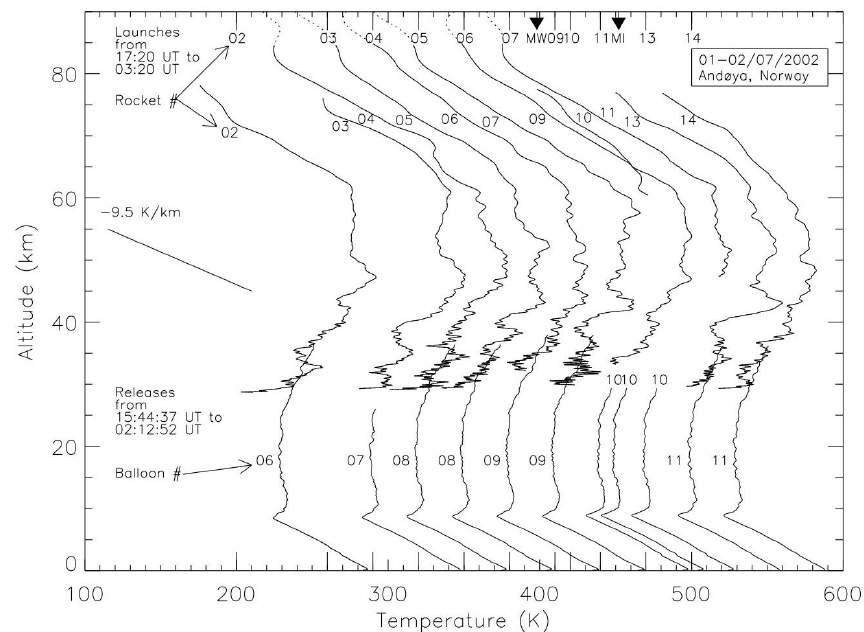
Fig. 7. Waterfall plot of the vertical temperature profiles measured by each rocket and balloon flight launched in the 1–2 July 2002 sequence at ARR and listed in Table 3. Each temperature profile is offset proportionally to the time between FS launches. The closest balloon measurement in time is matched with each rocket flight. The time for the MaCWAVE and MIDAS launches is indicated at the top. The profiles are dotted above 85km where the accuracy rapidly degrades. Note that the temperatures at the lowest altitudes for the falling spheres become distorted because of sphere collapse. This also applies to the profiles in Figs. 8, 13 and